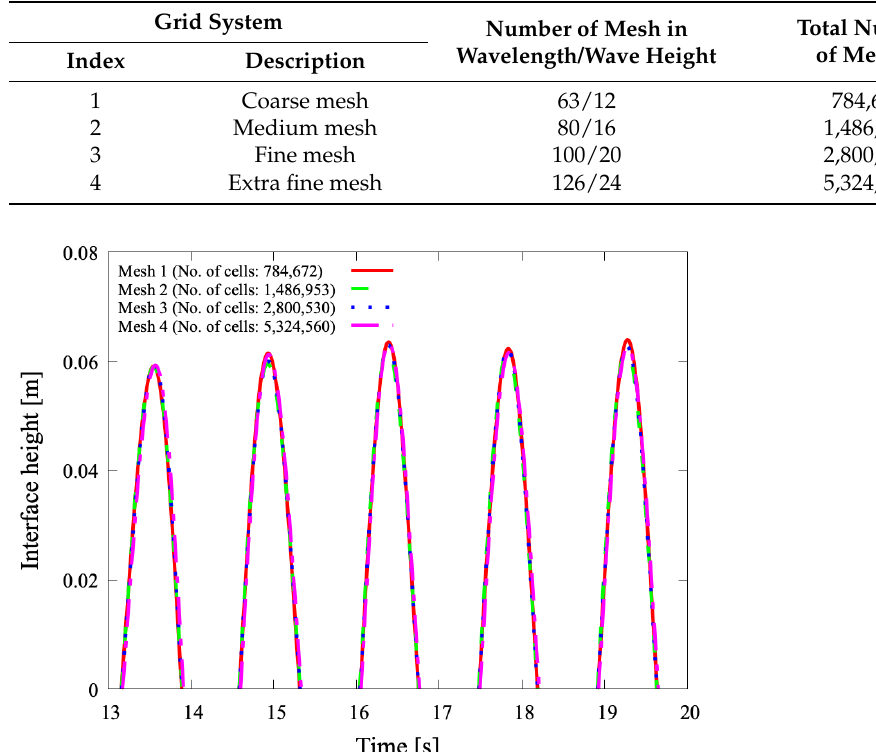
Table 3. Grid sizes for grid convergence test.